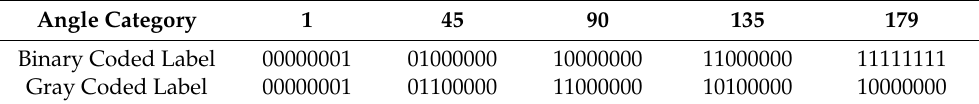
Table 2. The binary coded label and gray coded label corresponding to the angle categories. Angle Category 1 45 90 135 179 Binary Coded Label 00000001 01000000 10000000 11000000 11111111 Gray Coded Label 00000001 01100000 11000000 10100000